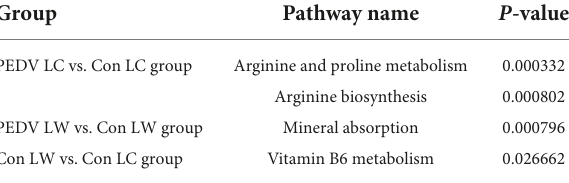
TABLE 7 Significant enrichment pathways for jejunal differential metabolites.